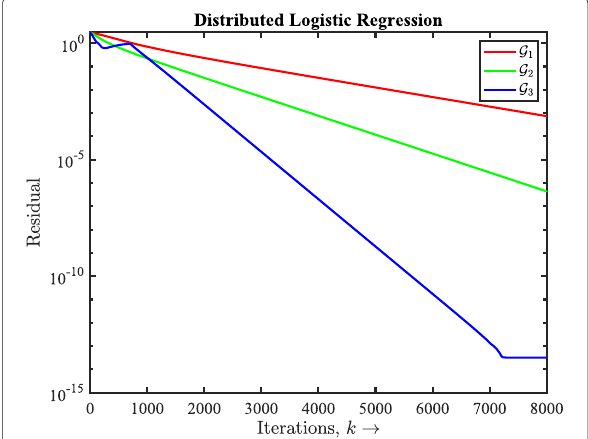
Fig. 4 Influence of network sparsity on the performance of